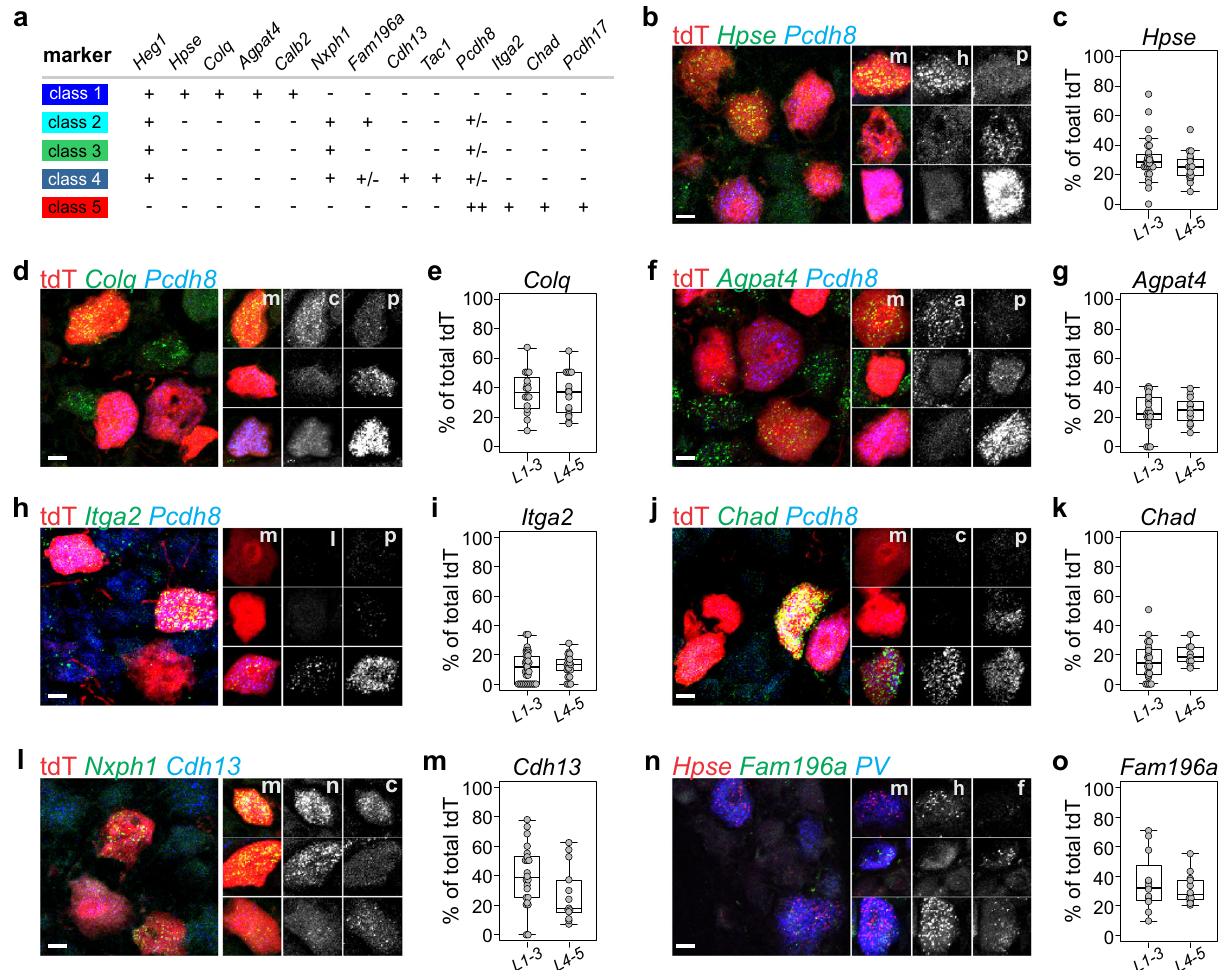
Fig. 3 Validation of molecularly distinct proprioceptor subtypes. a Summary of transcripts examined in validation assays. Transcript expression levels are indicated by “ ++ ” (high expression levels in most neurons), “ + ” (intermediate expression level in most neurons), “ + / − “ (lower expression levels in all or a subset of neurons), or “–“ (no or nearly no expression). b – g Expression of cluster I transcripts Hpse , Colq , and Agpat4 in relation to expression of the cluster 5 transcript Pcdh8 in ≥ p56 lumbar DRG of PVRx3:tdT mice. In b , d , f , images of individual neurons represent examples of observed transcript combinations other than those observed in the main image. High levels of Hpse (h) (in b ), Colq (c) (in d ), or Agpat4 (a) (in f ) transcript generally are mutually exclusive with high levels of Pcdh8 (p) transcript (m indicates merged image). Percentage of Hpse + tdT + neurons ( c ), Colq + tdT + neurons ( e ), or Agpat4 + tdT + neurons ( g ) (of total tdT + ) in ≥ p56 rostral (L1-3) or caudal (L4-5) lumbar DRG of PVRx3:tdT animals. Mean percentage± S.E.M. Hpse (L1-3): 30.1 ± 2.8%, n = 28 sections; Hpse (L4-5): 25.4 ± 2.2%, n = 19 sections; Colq (L1-3): 36.7 ± 3.5%, n = 16 sections; Colq (L4-5): 36.1 ± 3.6%, n = 16 sections; Agpat4 (L1-3): 23.2 ± 2.8%, n = 21 sections; Agpat4 (L4-5): 24.7 ± 2.8%, n = 11 sections. h – k Expression of the cluster 5 transcripts Itga2 , Chad , and Pcdh8 in ≥ p56 lumbar DRG of PVRx3:tdT mice. In h , j , images of individual neurons represent examples of observed transcript combinations other than those observed in the main image. High transcript levels of Itga2 (i) (in h ) or Chad (c) (in j ) generally overlap with high levels of Pcdh8 (p) transcript expression (m indicates merged image). i , k Percentage of Itga2 + tdT + neurons ( i ) or Chad + tdT + neurons ( j ) (of total tdT + ) in ≥ p56 rostral (L1-3) or caudal (L4-5) lumbar DRG of PVRx3: tdT animals. Mean percentage ± S.E.M. Itga2 (L1-3): 11.5 ± 1.7%, n = 34 sections; Itga2 (L4-5): 12.4 ± 1.6%, n = 21 sections; Chad (L1-3): 15.9 ± 2.6%, n = 23 sections; Chad (L4-5): 19.5 ± 2.4%, n = 9 sections. l Expression of cluster 2 – 4 transcript Nxph1 and cluster 4 transcript Cdh13 in ≥ p56 PVRx3:tdT DRG. Images of individual neurons represent examples of observed transcript combinations other than those observed in the main image. Single neuron analysis con fi rms that a subset of Nxph1 (n) neurons co-express Cdh13 (c; m indicates merged image). m Percentage of Cdh13 + tdT + neurons (of total tdT + ) in adult PVRx3:tdT DRG. Mean percentage ± S.E.M. Cdh13 (L1-3): 39.6 ± 4.5%, n = 22 sections; Cdh13 (L4-5): 27.3 ± 5.3%, n = 13 sections. n Expression analysis of Hpse (cluster 1) , Fam196a (cluster 2 and 4), and PV in adult wild type DRG indicates the presence of cluster 1 Hspe + Fam196a off , and cluster 2 or 4 Hspe off Fam196a + PV neurons. Images of individual neurons represent examples of observed transcript combinations other than those observed in the main image. A few cluster 1 neurons coexpress Hspe and Fam196a (see also Fig. 2g). o Percentage of Fam196a + tdT + neurons (of total tdT + ) in adult PVRx3:tdT DRG. Mean percentage ± S.E.M. Fam196a (L1-3): 35.9 ± 5.7%, n = 12 sections; Fam196a (L4-5): 31.4 ± 3.0%, n = 12 sections. Similar data obtained from at least three ( b , d , f , h , j , l , n ) biological replicates. In boxplots ( c , e , g , I , k , m , o ), boxes indicate medians and 25th/75th percentiles, and whiskers extend to the furthest point <1.5 standard deviations from the mean. Scale 10 μ